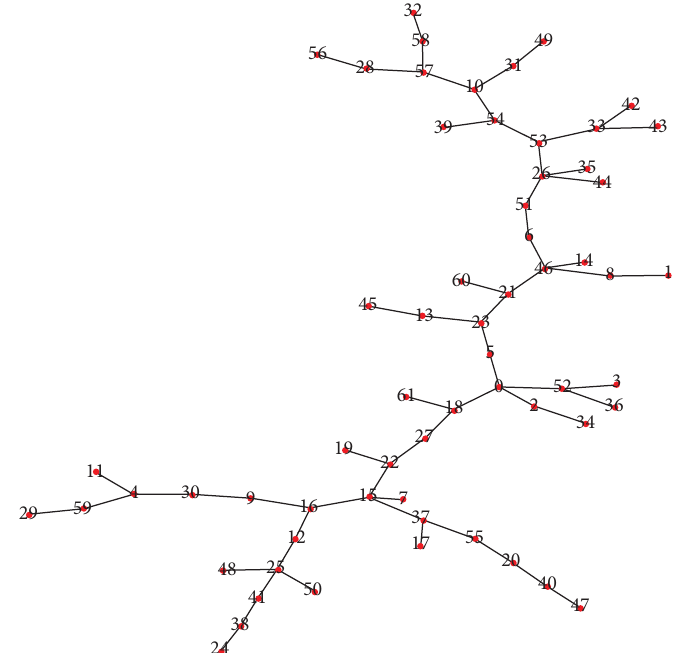
Figure 4: Energy stock jump complex network from April 2017 to October 2017.